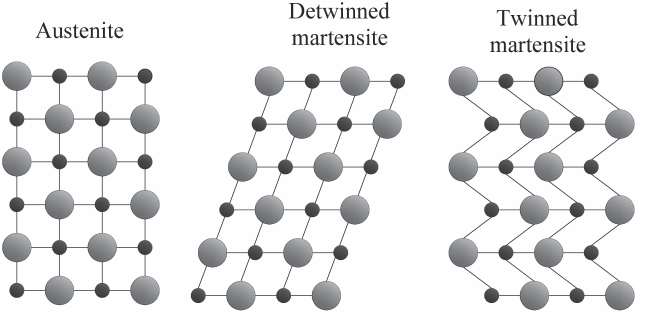
Figure 5. Different crystal structures of SMAs.